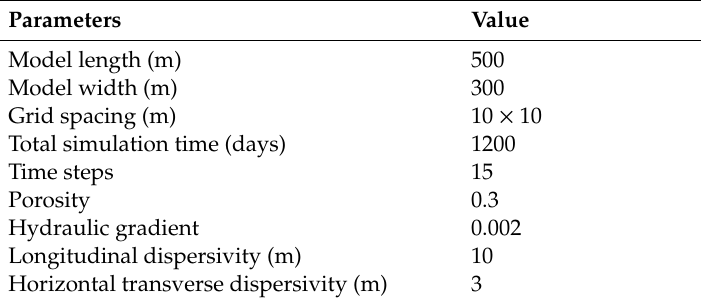
Figure 7. The conceptual model of the two-dimensional confined aquifer considered in Case 2. The background of the model depicts the spatial distribution of the log-conductivity field. The black dot and red square denotes the contaminant source and the observation well, respectively. Table 3. Basic parameters of the reactive transport model in Case